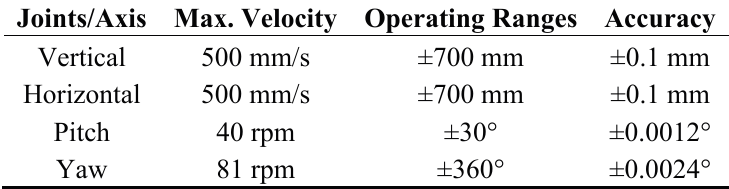
Table 1. Properties of the robotic platform